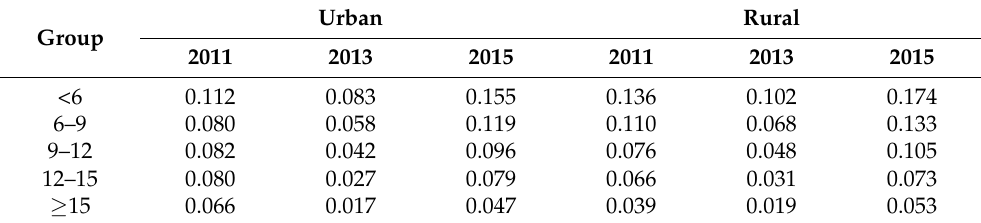
Table 5. Households’ financial vulnerability by education years of household heads.